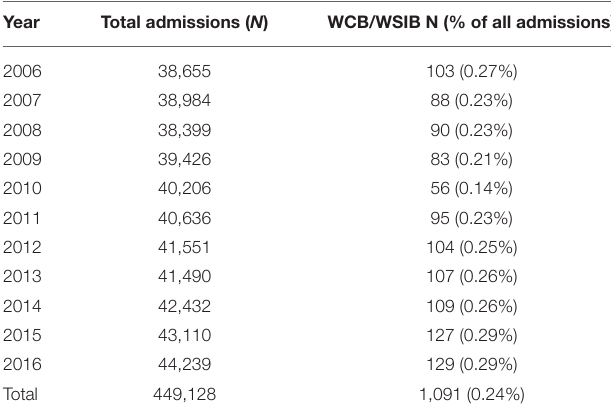
TABLE 1 | Number of WSIB admissions between January 1, 2006 and December 31,